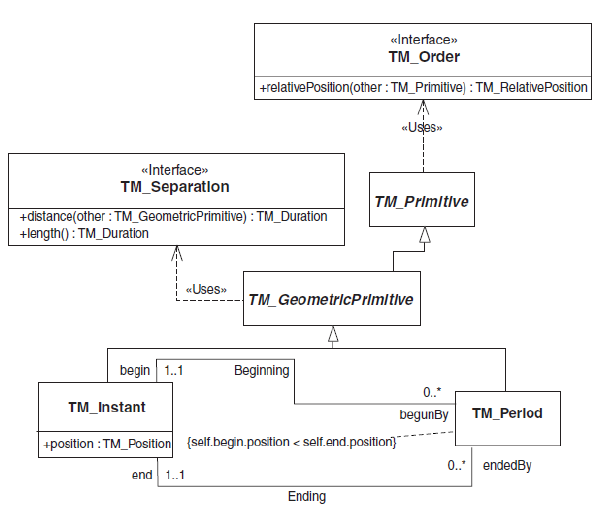
Figure 2 Temporal geometric primitives (ISO,